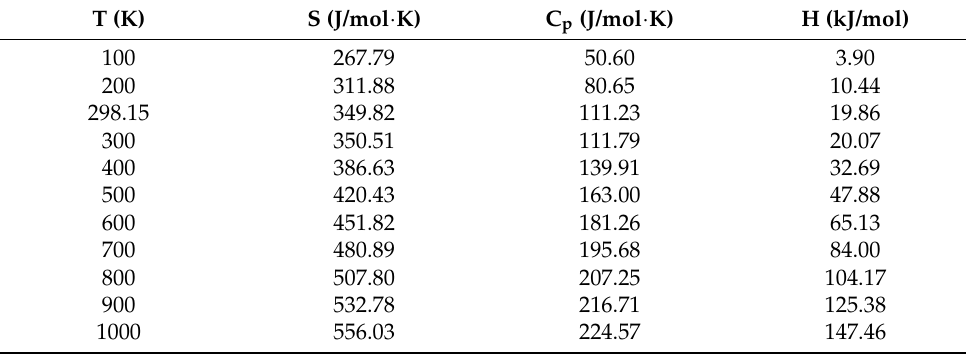
Table 5. Calculated thermodynamic properties for 3-Br-2-HyP